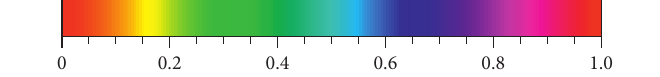
Figure 10: Mapping relationship between pavement performance and